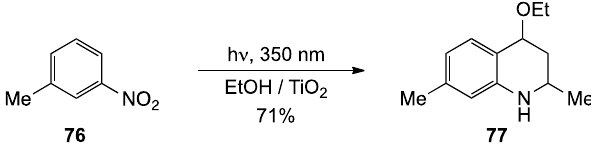
Scheme 19. A photochemical synthesis of tetrahydroquinolines.